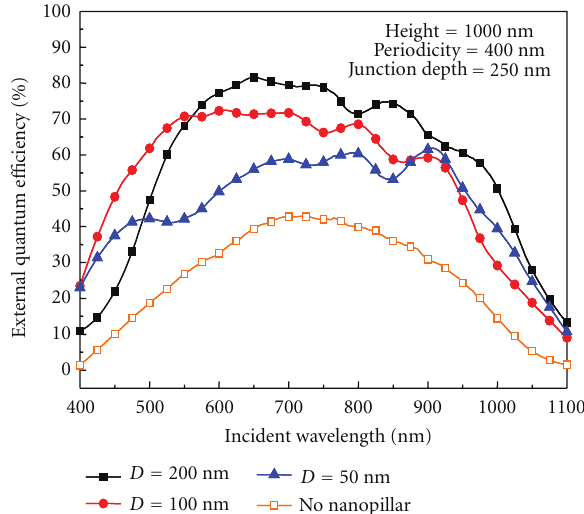
Figure 21: External quantum e ffi ciency for various pillar diameter showing best result for 200 nm pillar diameter under AM 1.5 G 100mWcm − 2 illumination. (Reprinted with permission from [8]. [2010]